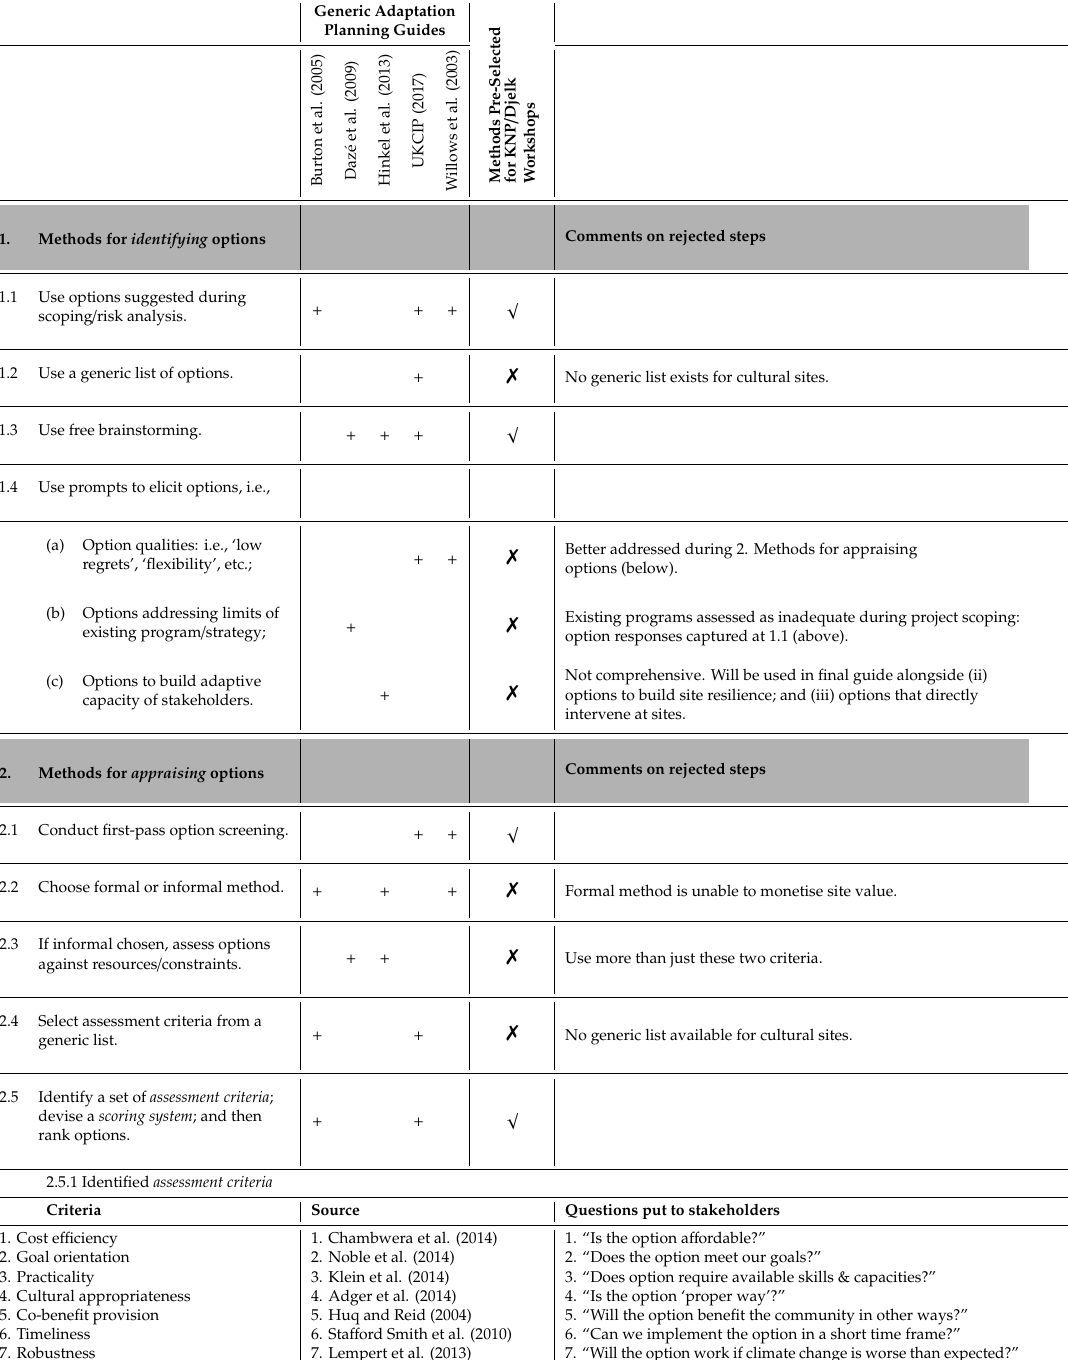
Table 1. Comparison and selection of options-analysis methods. A plus ( + ) indicates that the method features in a given generic adaptation planning guide. A tick ( the method for the Djelk and Kakadu Ranger workshops, during which rangers endorsed its use.